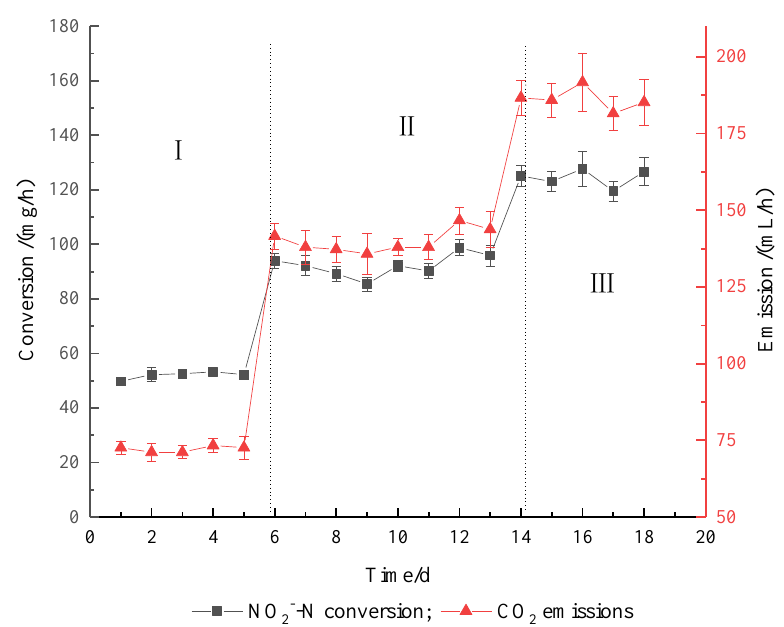
Figure 4. Relationship between CO 2 emissions and NO 2 − -N conversion during the partial nitrification stage; Stages I, II, and III indicate that HRT is 14, 10, and 6 h, respectively.